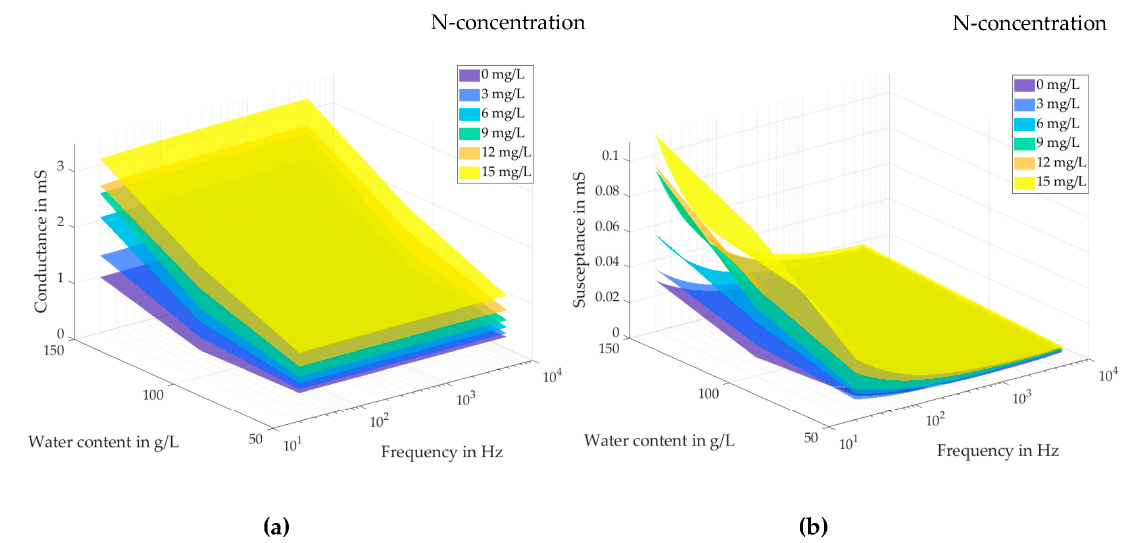
Figure 3. Measured test cell conductance ( a ) and susceptance ( b ) as a function of the nitrate-N concentration (in mg/L) and of the water content (in g/L) in synthetic soil (quartz sand), and of frequency, reprinted from Ref. [43].